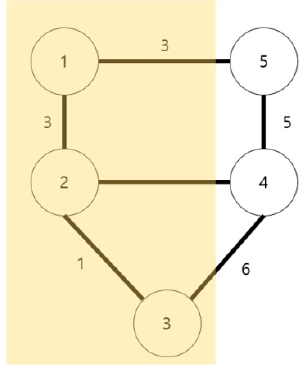
Figure 9. Proposed Algorithm (1).